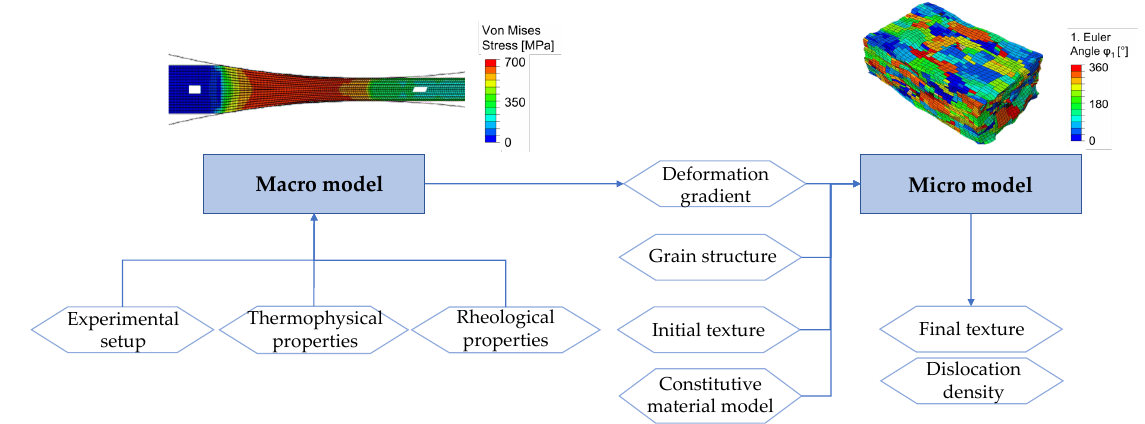
Figure 4. Relevant input and output data of the multi-scale simulation for texture evolution in cold